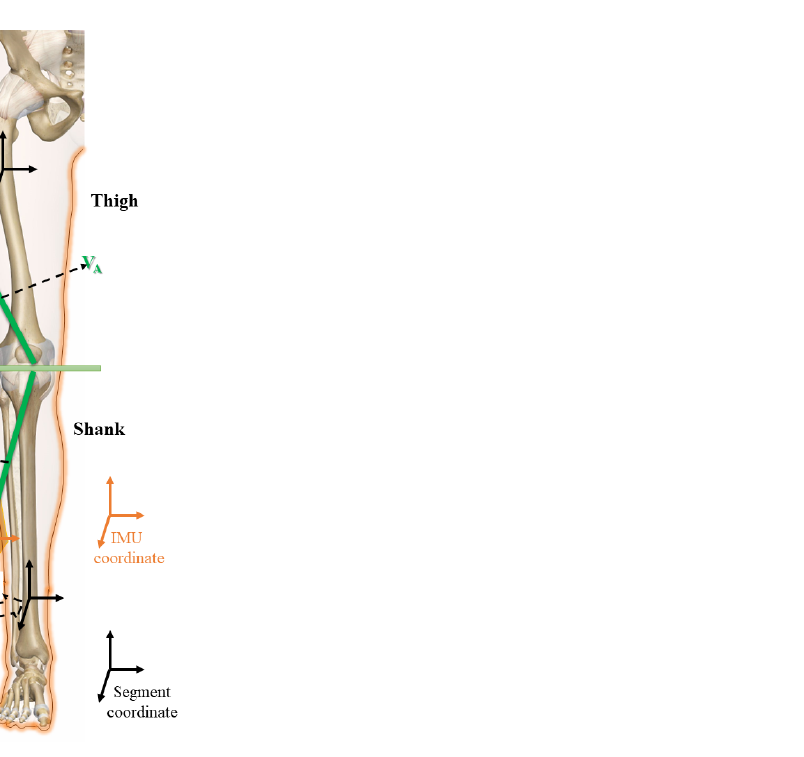
Figure 1. Illustrations of joint constraints and I2S alignment. The schematic diagram of each vector in the joint constraint model is shown with colored arrows; the coordinates of IMU and segment are shown with different colors; the black dashed arrows indicate the alignment of IMU to